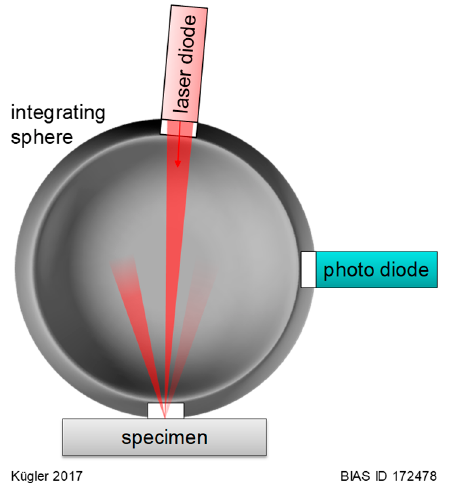
Figure 2. Schematic sketch of the measurement system for detecting the reflection share for determining the absorption of the irradiated specimen surface [24].